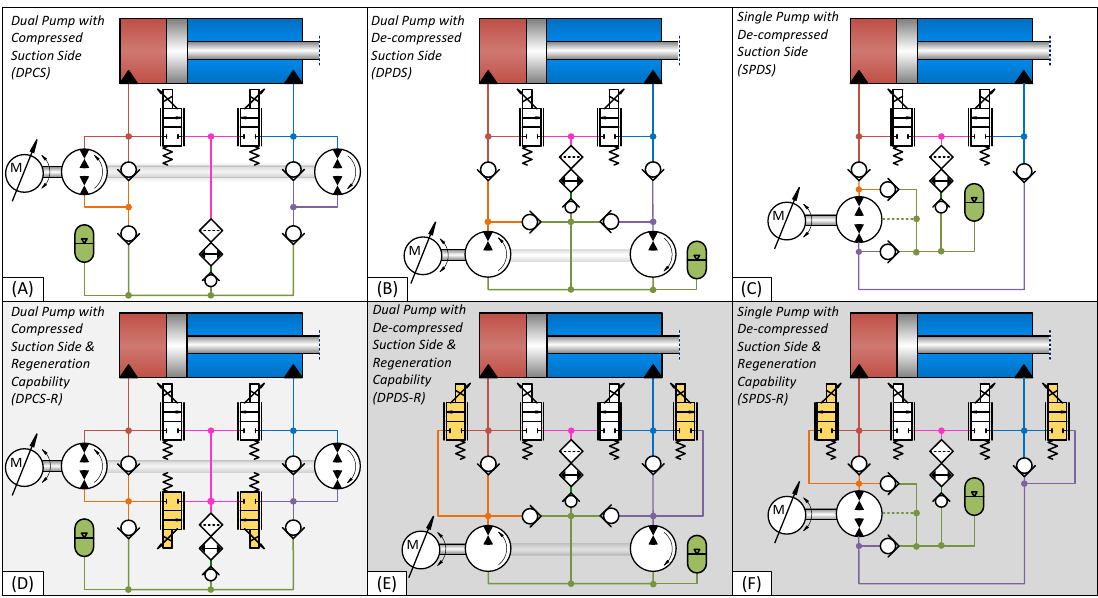
Figure 3. Different architectures contained in the proposed class of drives. Drives ( D – F ) are modifications of drives ( A – C ), with energy regeneration capability. The yellow valves allowing for energy regeneration are denoted auxiliary valves , whereas the white valves are denoted transmission line valves